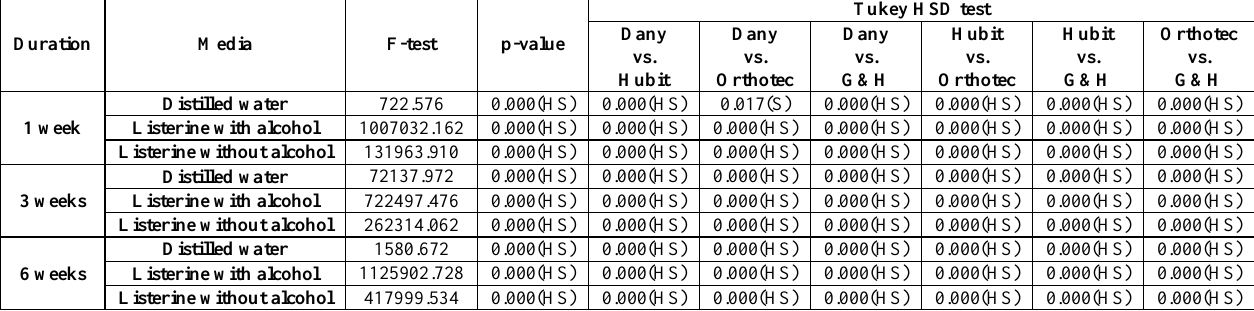
Table 2: ANOVA test and Tukey HSD test results of aesthetic arch wires and the effect of aesthetic arch wires